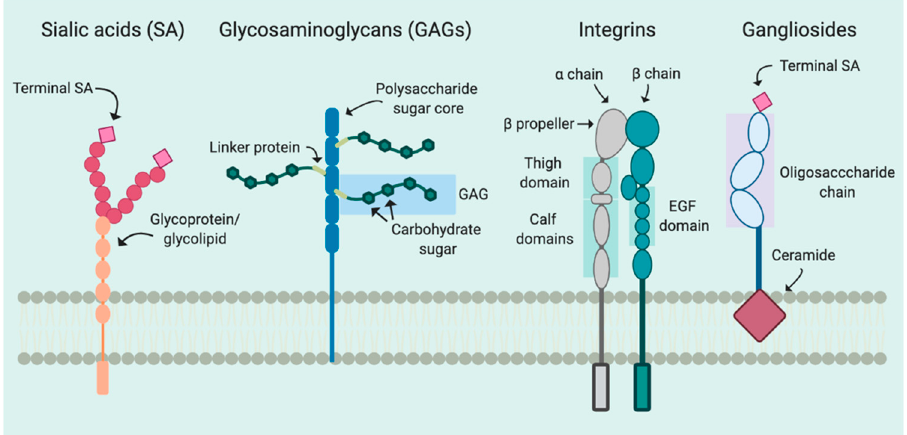
Figure 1. Attachment factors commonly used by polyomaviruses. Sialic acid-containing receptors typically consist of glycoproteins or glycolipids (orange) with attached mono or oligosaccharide backbones (pink circles) and terminal sialic acid residues (pink diamonds). Glycosaminoglycans contain repeating disaccharides (green hexagons) and are attached to the polysaccharide sugar core (blue) by link proteins (light green). Integrins are heterodimeric proteins comprised of α and β chains containing β domains attached to thigh and calf domain regions. β chains further contain epidermal growth factor (EGF) binding domains. Gangliosides are glycosphingolipids with a ceramide moiety embedded in the lipid bilayer and an oligosaccharide chain containing one or more sialic acids. Gangliosides may also contain a terminal sialic acid residue (pink diamond). Figure created with BioRender.com.